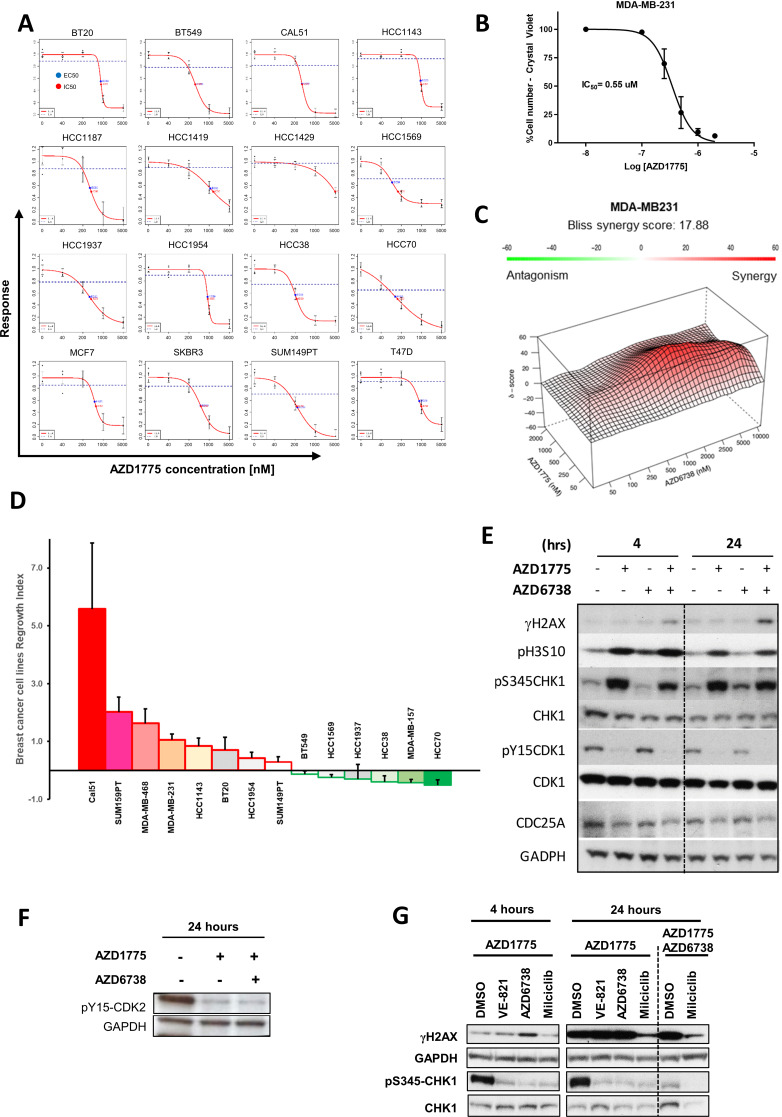
Differential response and recovery of basal-like breast cancer (BLBC) cell lines to AZD1775 monotherapy.(A) AZD1775 dose-response curves of the panel of BC cell lines representing luminal and basal-like breast cancer subtypes (analysed by high-content imaging screening, see also Materials and methods, Figure 6—figure supplement 1F and Supplementary file 1). Response parameters were set to the area above the response curve, Activity Area, concentration of compound achieving 50% of the maximum effect, EC50, or concentration of compound achieving 50% reduction in cell number, IC50. (B) AZD1775 dose-response analysed by crystal violet staining assay in MDA-MB-231 cells treated with AZD1775 for 72 hr. Data are represented as mean ± SD calculated from three independent experiments (IC50 = 0.55 µM). (C) MDA-MB-231 cells were treated with the indicated compounds at different concentrations for three days. Drug synergies from dose-response matrices are shown as surface plots to visualize interaction at different drug concentrations. Plots were generated and synergy scores calculated based on the Bliss model using the publicly-available online tool SynergyFinder (Ianevski et al., 2017). Overall Bliss score = 17.88. Most synergistic area score = 32.61. (D) Quantification of recovery of proliferation following removal of AZD1775 in different BC cell lines. Cells were treated for three days and allowed to recover for an additional four days without the drugs. Regrowth was calculated by crystal violet stainings (Regrowth index; RI = OD after 4 days recovery minus OD after 3 days treatment, divided by OD 3 days treatment). Data are represented as mean ± SD calculated from three independent experiments. (E) Immunoblots of HCC1954 cells treated with the indicated drugs for 4 hr and 24 hr and probed with the specified antibodies. (F) Phosphorylation of Y15-CDK2 in response to AZD1775 (500 nM) or the combination (500 nM AZD1775 + 1 μM AZD6738) was assessed by immunoblot analysis. GAPDH was used as loading control. (G) Immunoblot analysis of γH2AX and CHK1 activation (MDA-MB-231 cells) in response to AZD1775 (500 nM) mono-treatment, or in combination with ATR inhibitors (1 μM) VE-821 and AZD6738, or CDK2 inhibitor Milciclib (1 μM), as indicated.